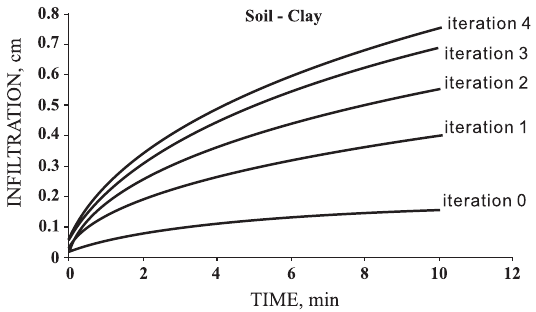
Figure 4. Infiltration rate as a function of time in clay material at each iteration level (loam content is zero at iteration zero and increases with each